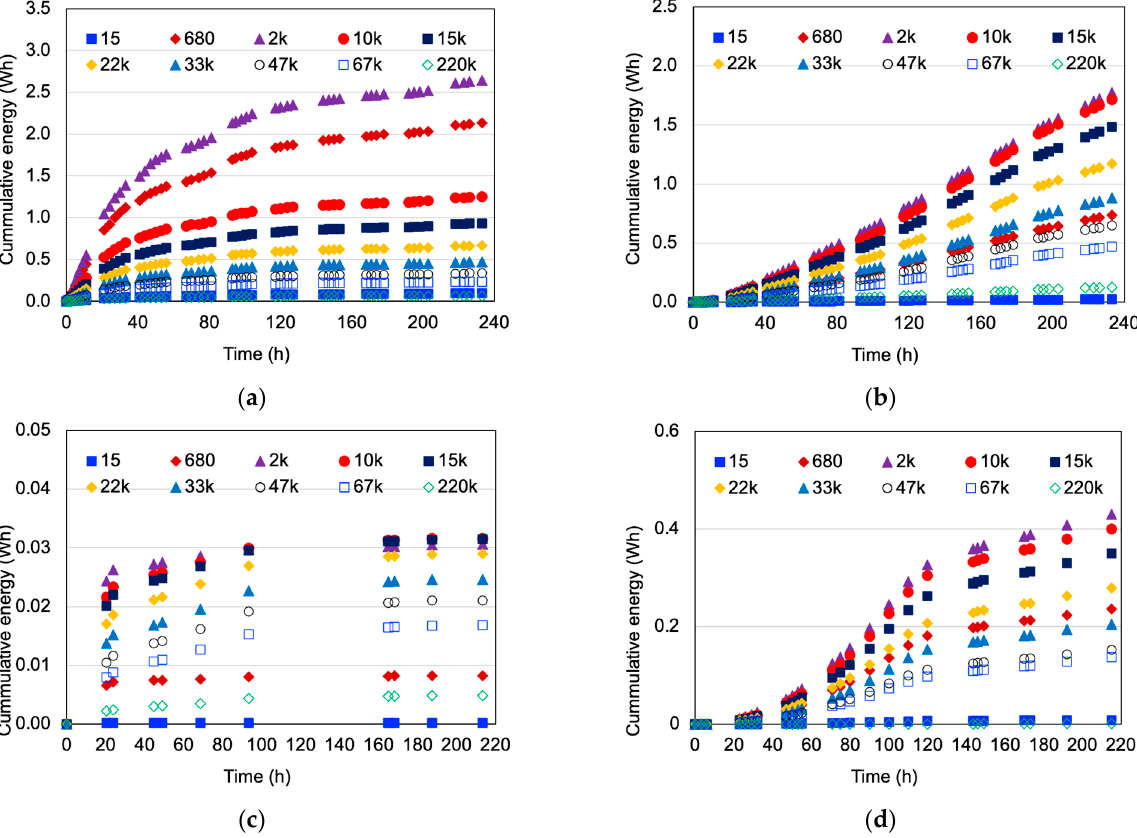
Figure 6. E ff ect of the external resistance ( Ω ) on the MFC energy generation. ( a ) Water and hydro- Figure 6. Effect of the external resistance ( Ω ) on the MFC energy generation. ( a ) Water and philically-treated graphene (DW-HTG); ( b ) HCl and hydrophilically-treated graphene (HCl-HTG); hydrophilically-treated graphene (DW-HTG); ( b ) HCl and hydrophilically-treated graphene (HCl- ( c ) Water and graphite (DW-G); ( d ) HCl and graphite (HCl-G). HTG); ( c ) Water and graphite (DW-G); ( d ) HCl and graphite